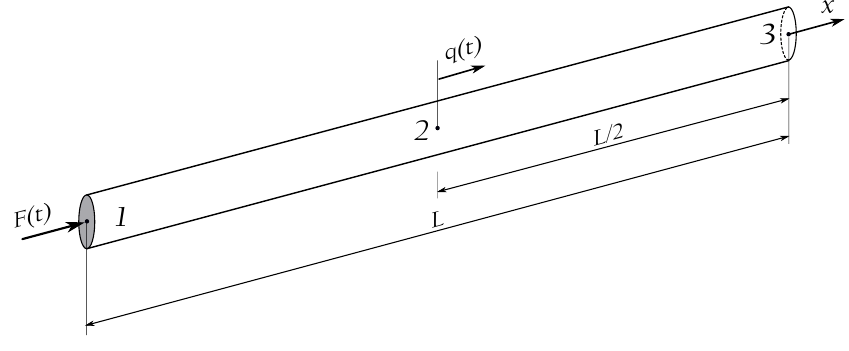
Figure 3. Geometry of a uniform aluminium